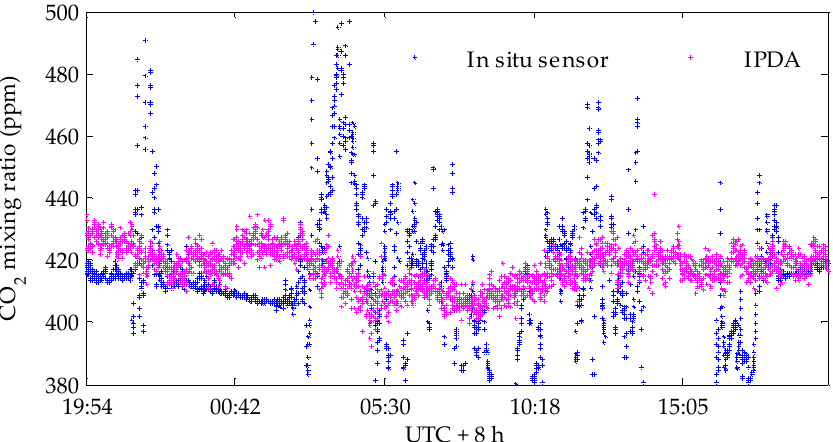
sensor on the 580 m horizontal path.